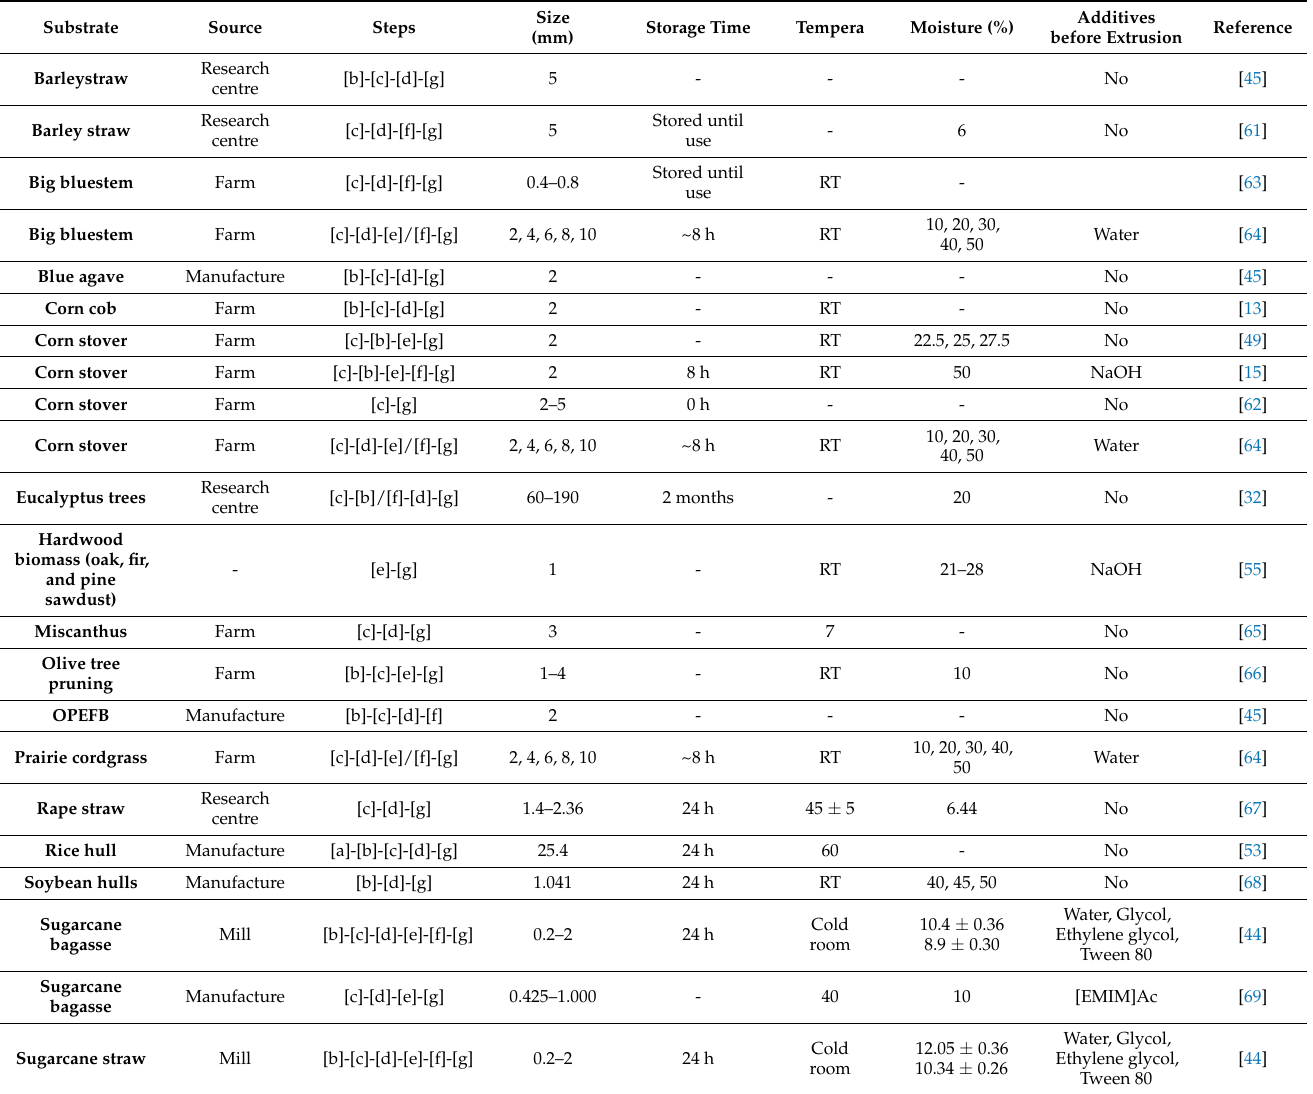
Table 3. Practices of biomass preparation before